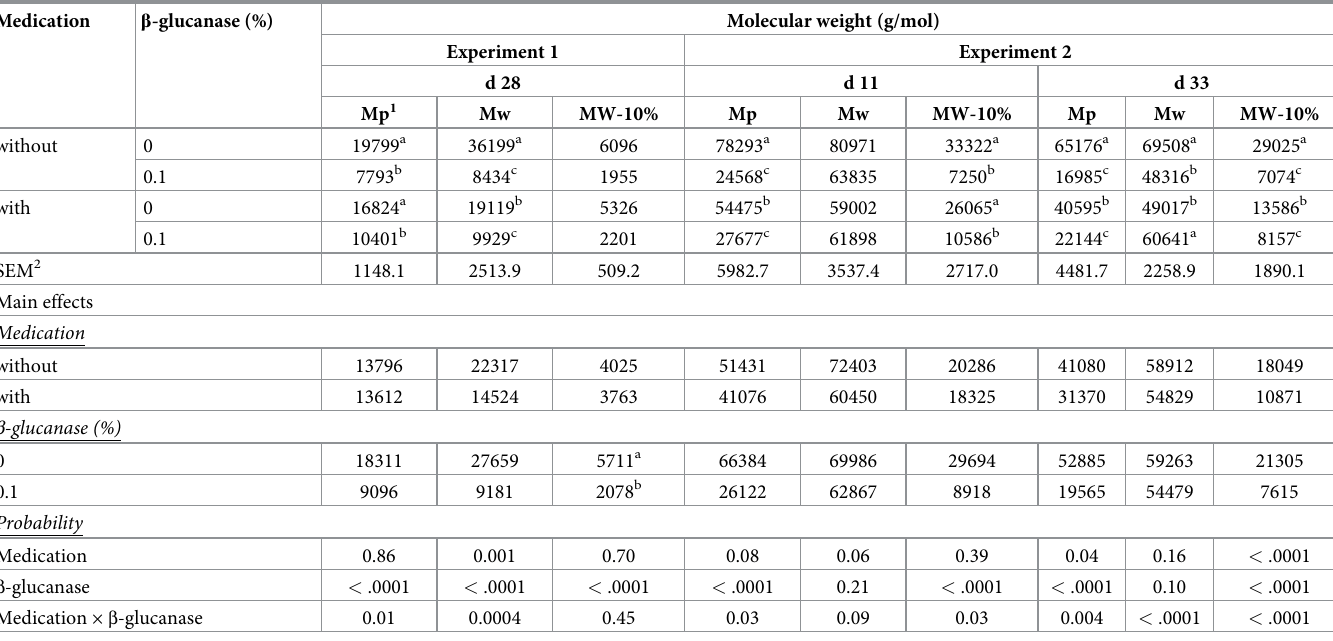
Table 2. Effects of diet medication and β -glucanase on β -glucan molecular weight in ileal content of broiler chickens. Medication β -glucanase